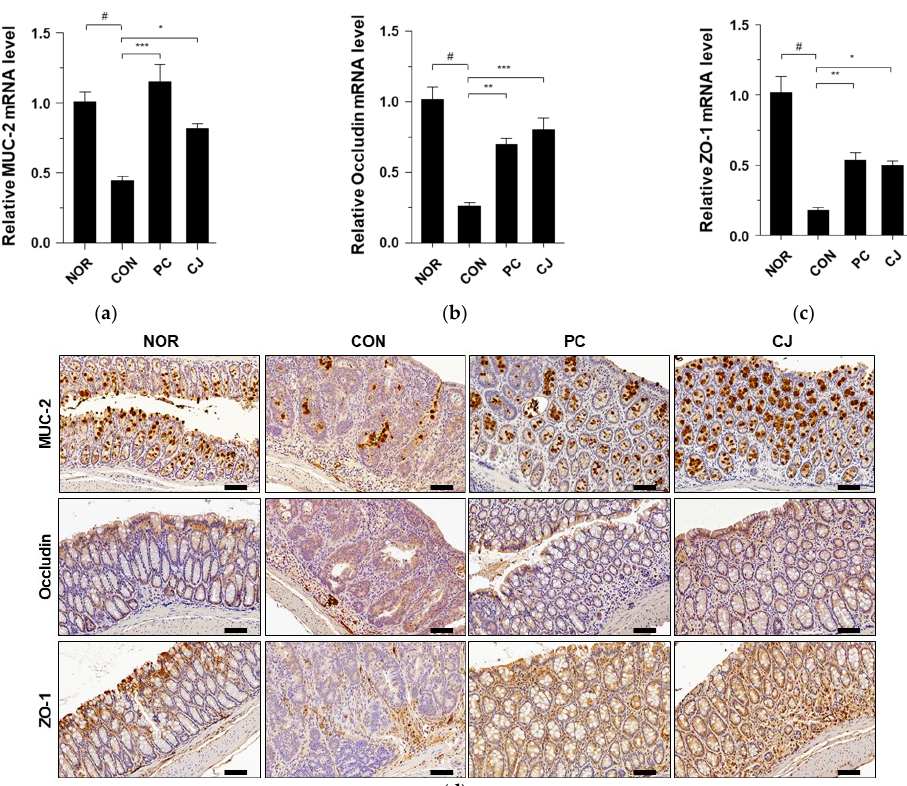
Figure 5. Effects of CJ on the expression of mucin-associated protein and tight junction proteins in mice with AOM/DSS-induced CAC. Shown are the mRNA levels of ( a ) Muc2, ( b ) occludin, and ( c ) ZO-1 in the different groups of mice. ( d ) Representative images of the colonic tissue immunohisto- chemically stained with MUC2, occludin, and ZO-1. Magnification, 200 X; scale bar, 60 µ m. Values are means ± standard deviation ( n = 8); NOR, normal group; CON, control group; PC, positive control group; CJ, cheonggukjang treated group. #, p < 0.05 versus normal group; ***, p < 0.001; **, p < 0.005; *, p < 0.05 versus control